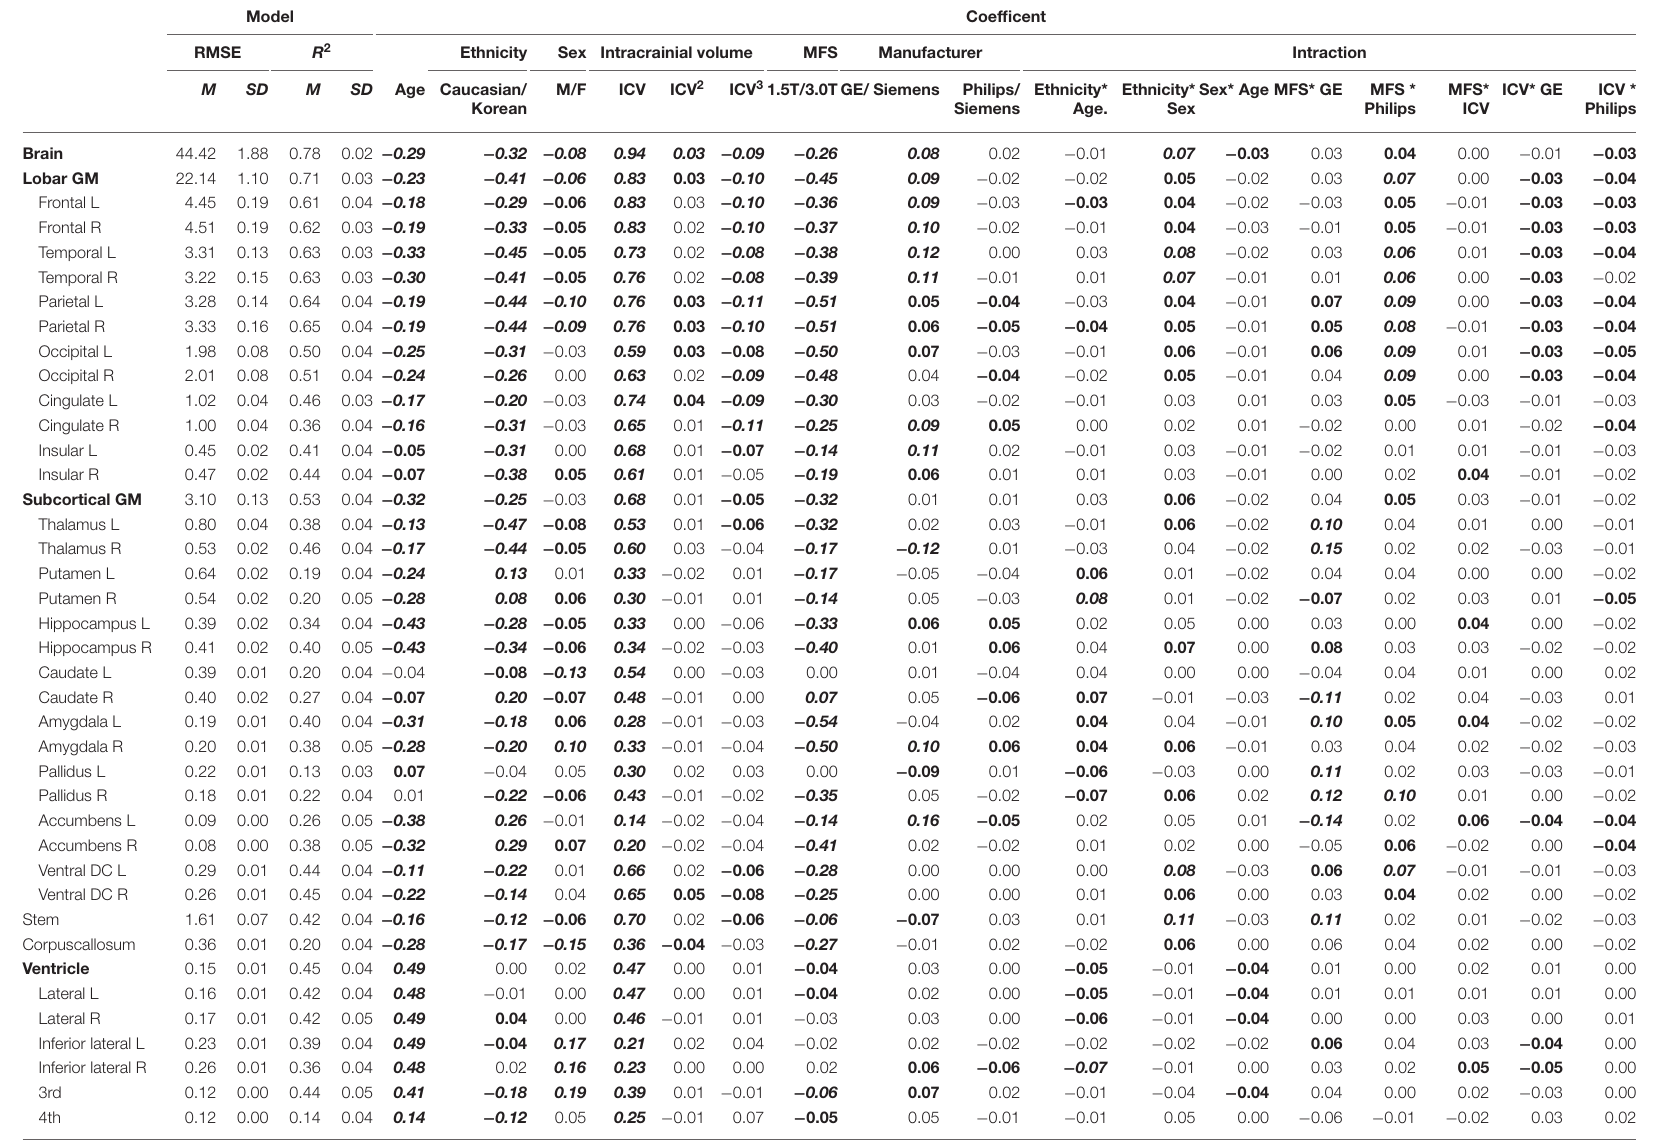
TABLE 2 | Standardized coefficients of the prediction model of lobar and subcortical gray matter